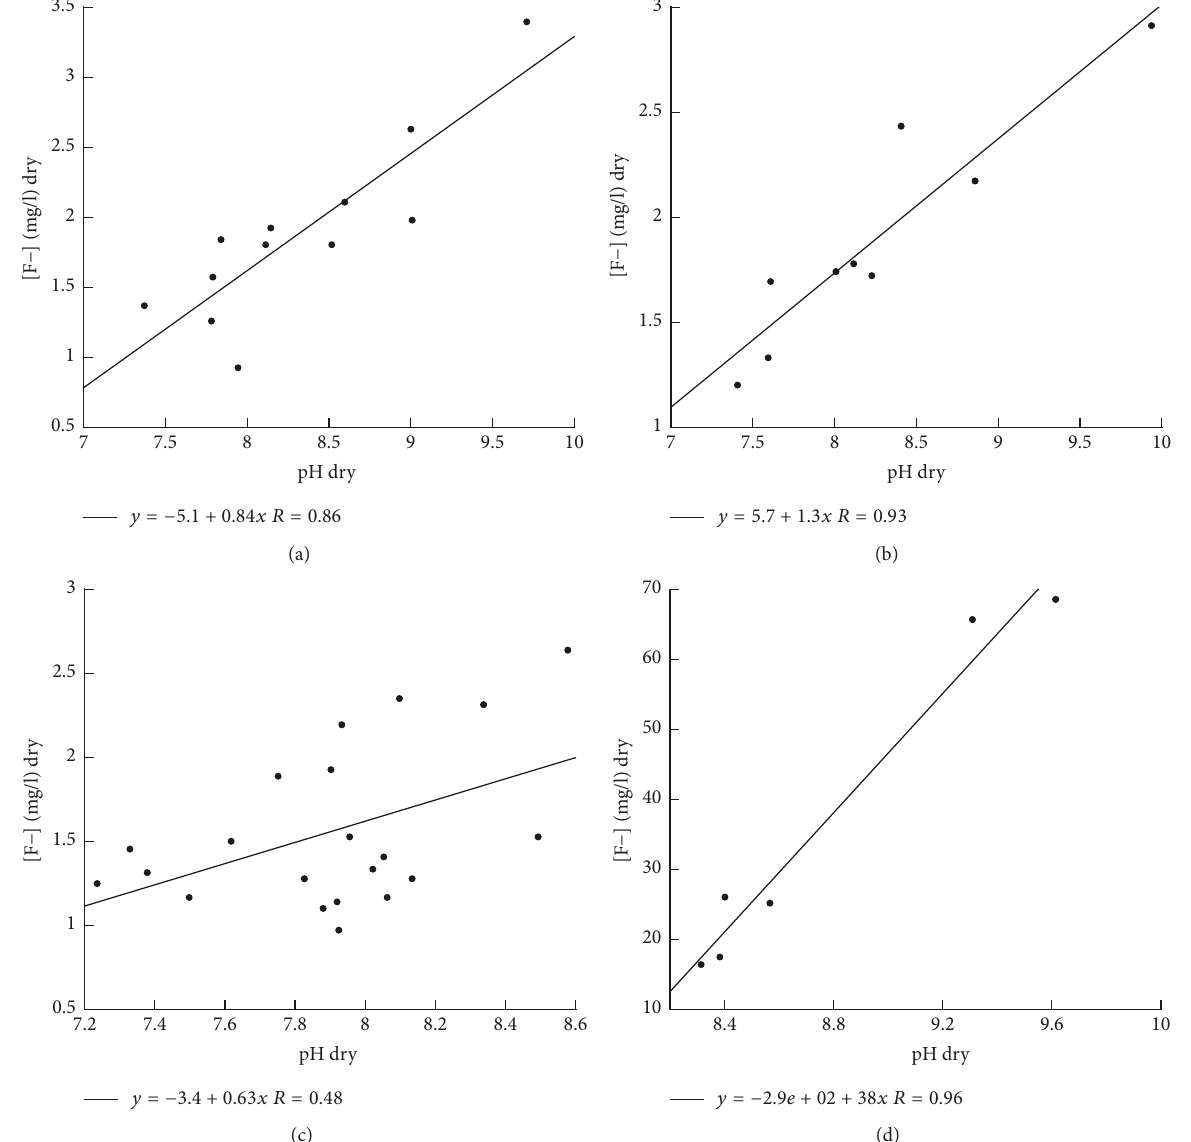
Figure 7: Correlation of fluoride with pH for the dry season in (a) Temi, (b) Nduruma, (c) Tengeru, and (d) Maji ya Chai.